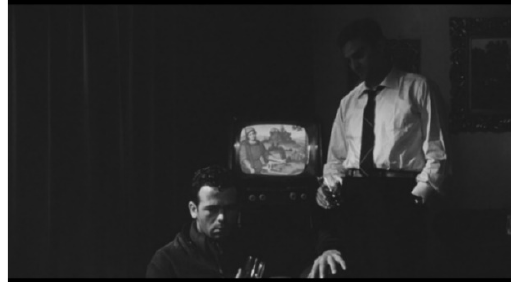
Figure 15 Screenshot from Rocco and His Brothers. (Goffredo Lombardo.)